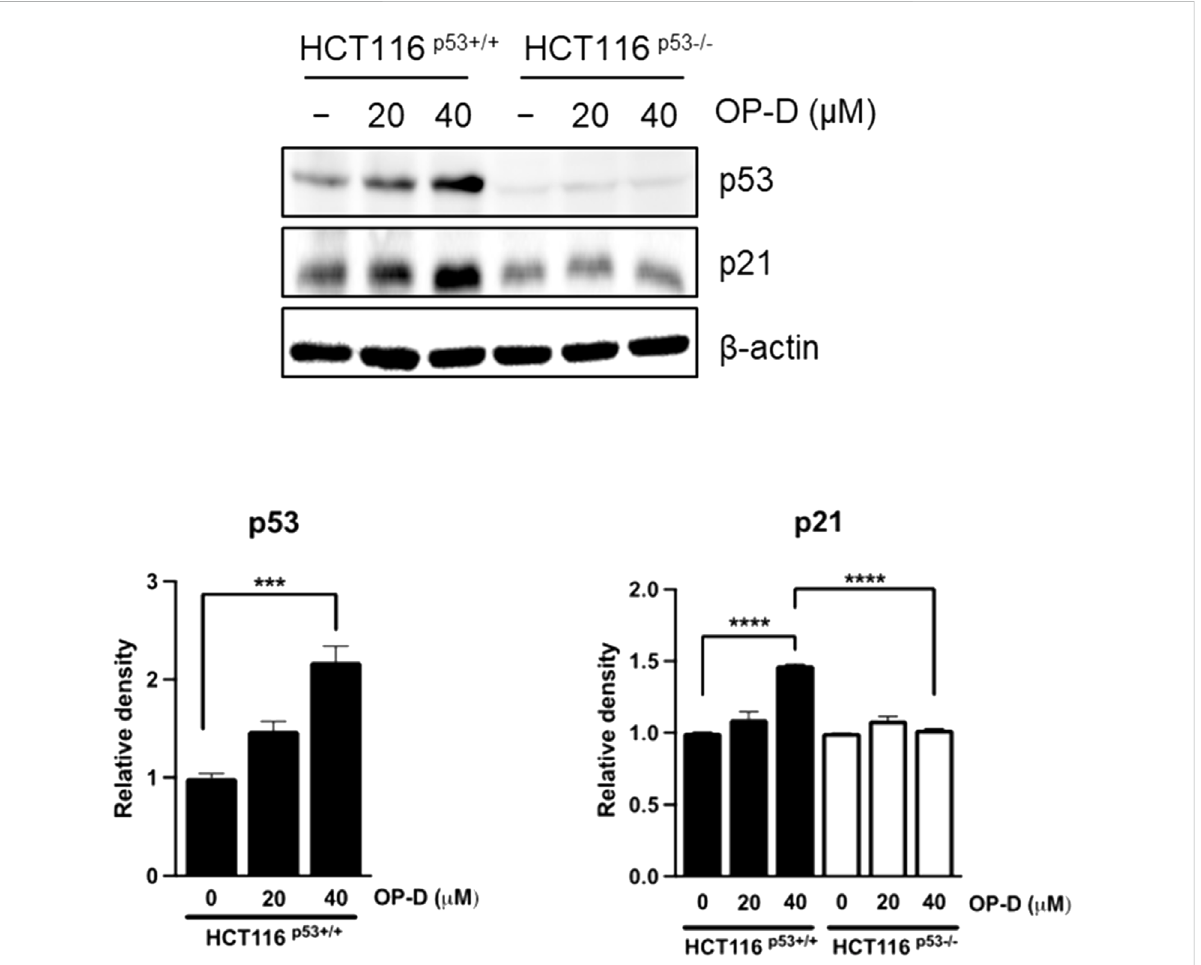
FIGURE 2 OP-D-inducedp53anditstargetgenep21inHCT116 p53+/+ andHCT116 p53 − / − cellsweretreatedwithOP-D(0,20,or40 μ M)for24 h.Celllysates were performed for p53, p21, and β -actin by Western blotting. Data represent means ± SD. *** p < 0.005, **** p < 0.001 versus untreated